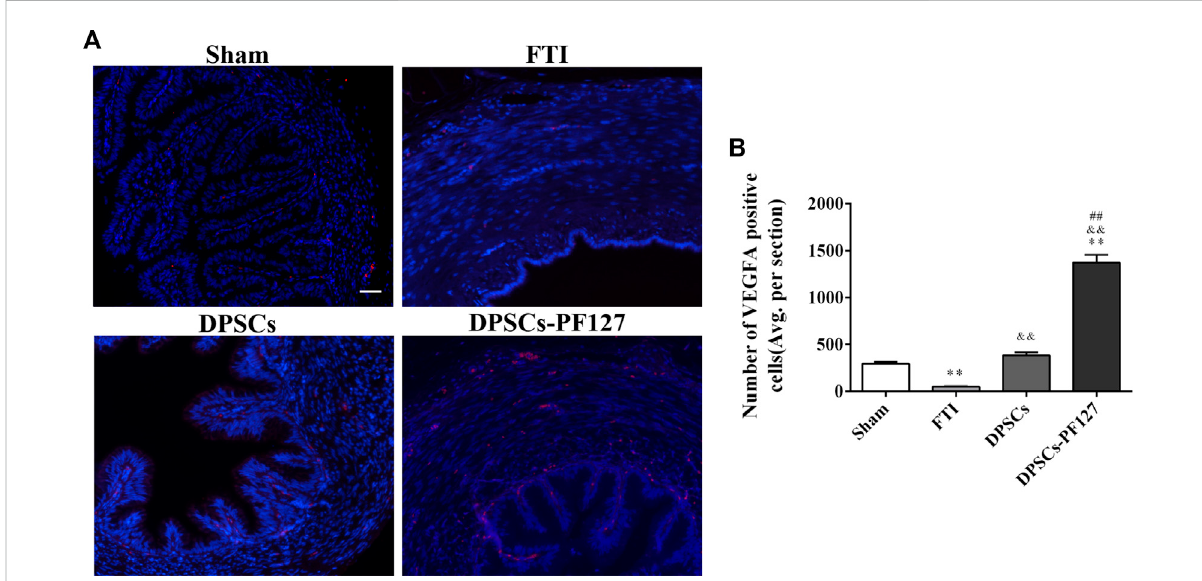
FIGURE 7 DPSCs-PF127 promotes angiogenesis of the FT at 4 weeks after injury. (A) Immuno fl uorescence staining for VEGF-A (red) of sections from the FT in each group. Scale bar: 50 µm. (B) Quantitative estimation of VEGF-A-positive cells from three independent sections. All data represent Mean values ±SEM. ** p < .01 versus the Sham group. && p < .01 versus the FTI group. ## p < .01 versus the DPSCs